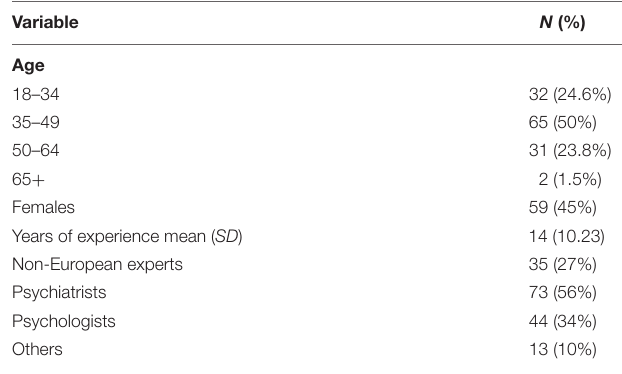
TABLE 1 | Characteristics of the experts ( N = 130) participating in the online